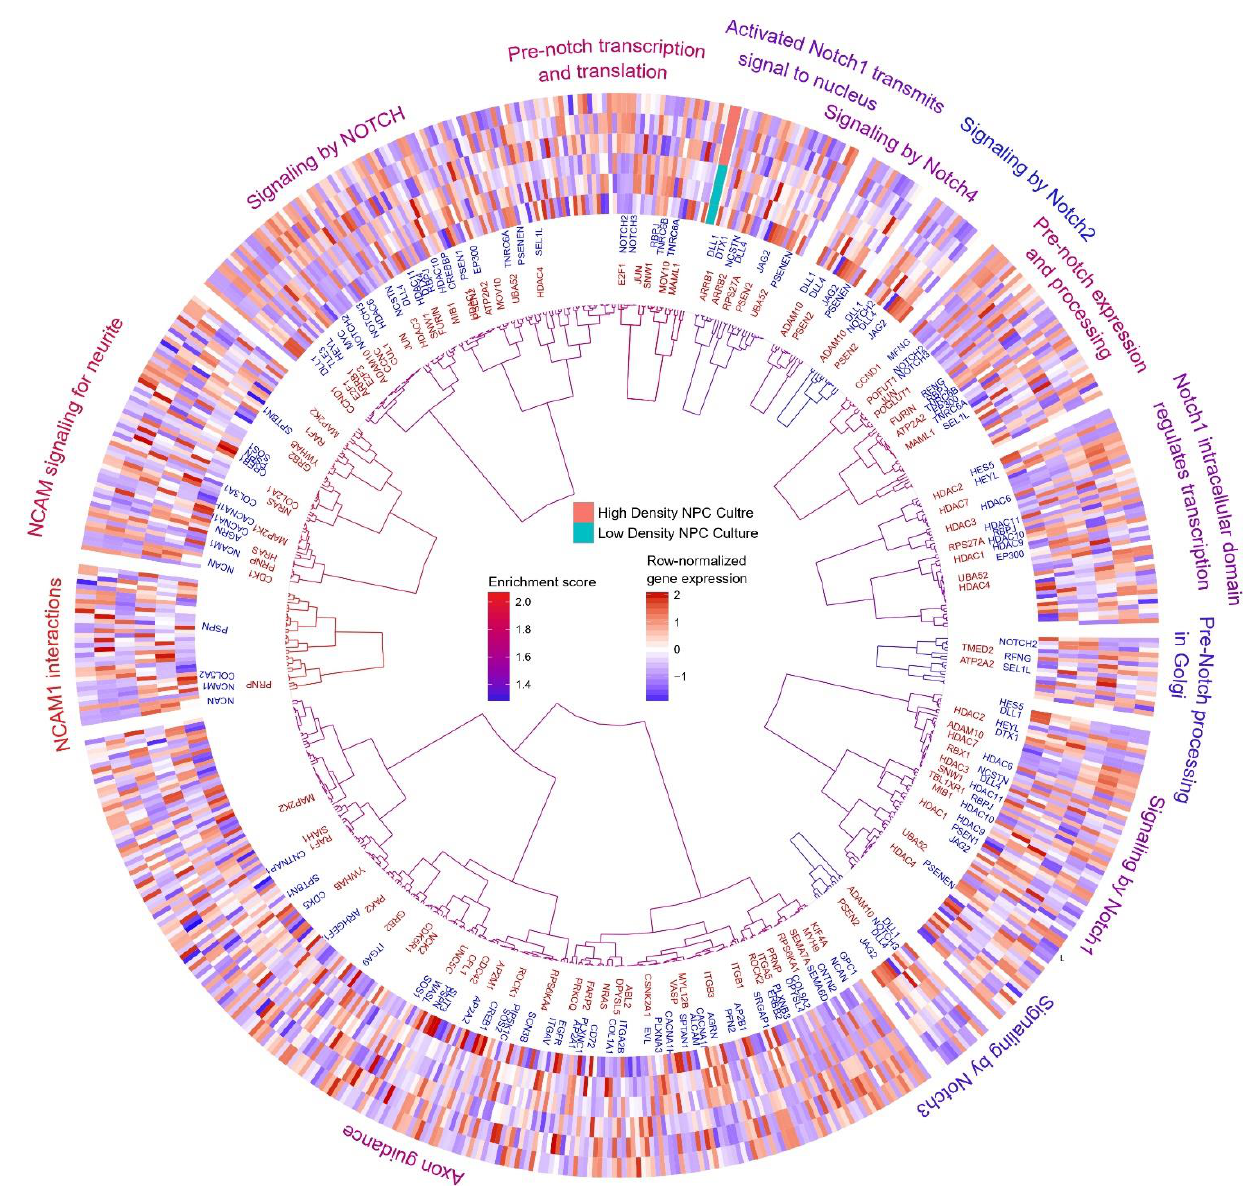
Figure 6. Differential activity of NOTCH signaling among low -and high-density cells. We hierar- chically clustered genes within each NOTCH signaling signature MSigDB Reactome (version 6.1, San Diego, USA) according to their transcription in low- and high-density samples. The colour of the dendrograms shows the pathway enrichment score. We plotted the name of each significantly upregulated gene (red) and downregulated gene (blue) next to the dendrogram. The circular heatmap shows the z-score of normalized gene expression.